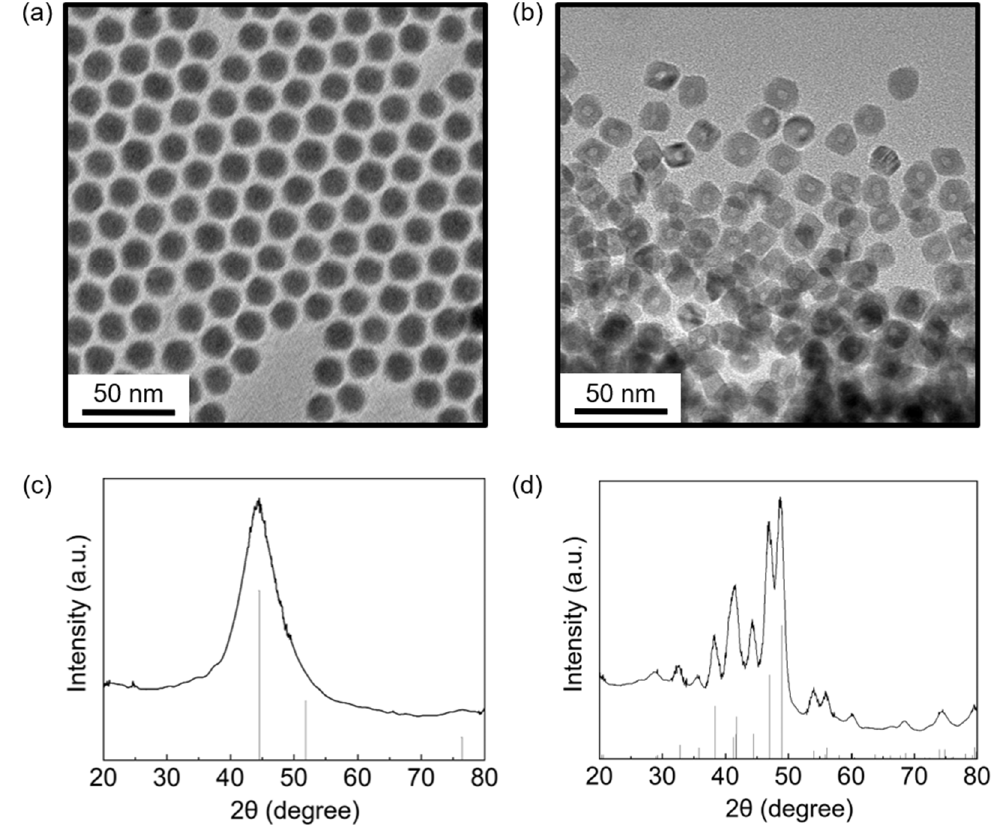
Figure 2. TEM images of ( a ) Ni and ( b ) Ni 12 P 5 synthesized at ( a ) 240 and ( b ) 280 °C (precursor concentration = 200 mM, surfactant: TBP, solvent: dioctyl ether) and XRD spectra of ( c ) Ni (a, JCPDS number 87-0712) and ( d ) Ni 12 P 5 (b, JCPDS number 74-1381) nanoparticles.